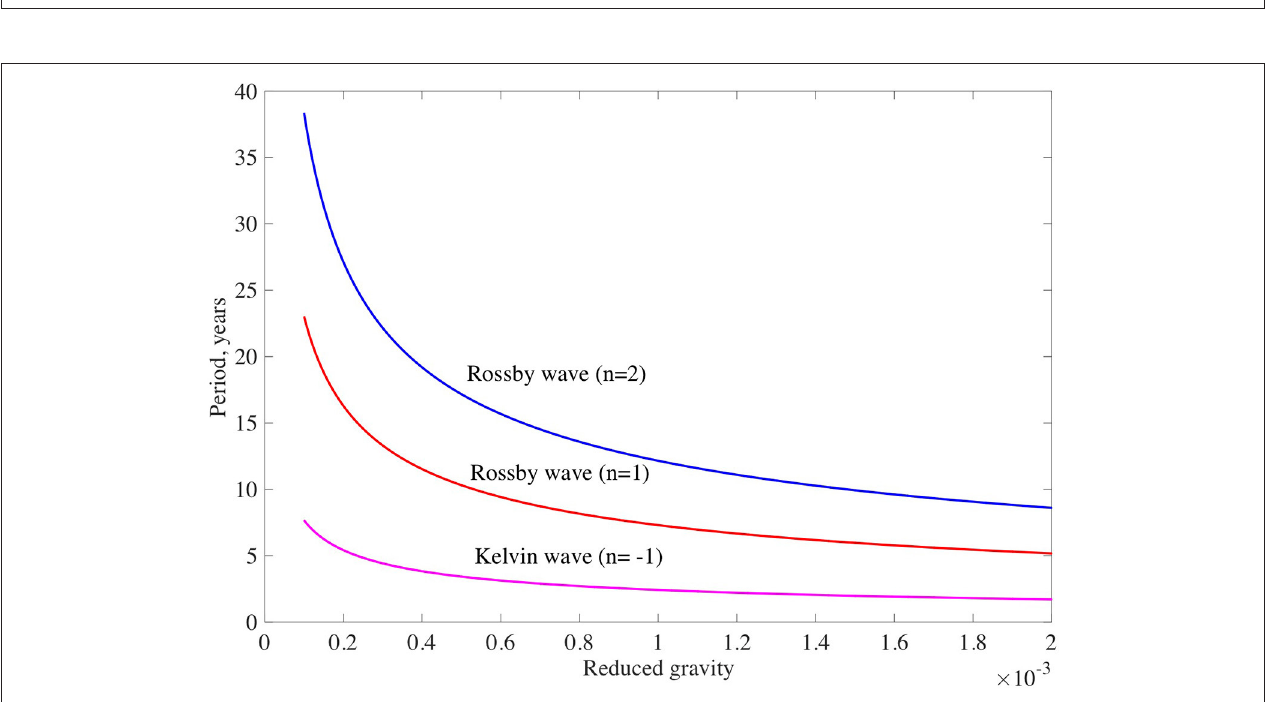
FIGURE 6 | Period of equatorial HD Rossby and Kelvin waves vs. the value of normalized reduced gravity, G . Red and blue lines correspond to n Rossby wave harmonics, respectively. Magenta line corresponds to HD Kelvin waves. Here the harmonics with the wavenumber of k x R